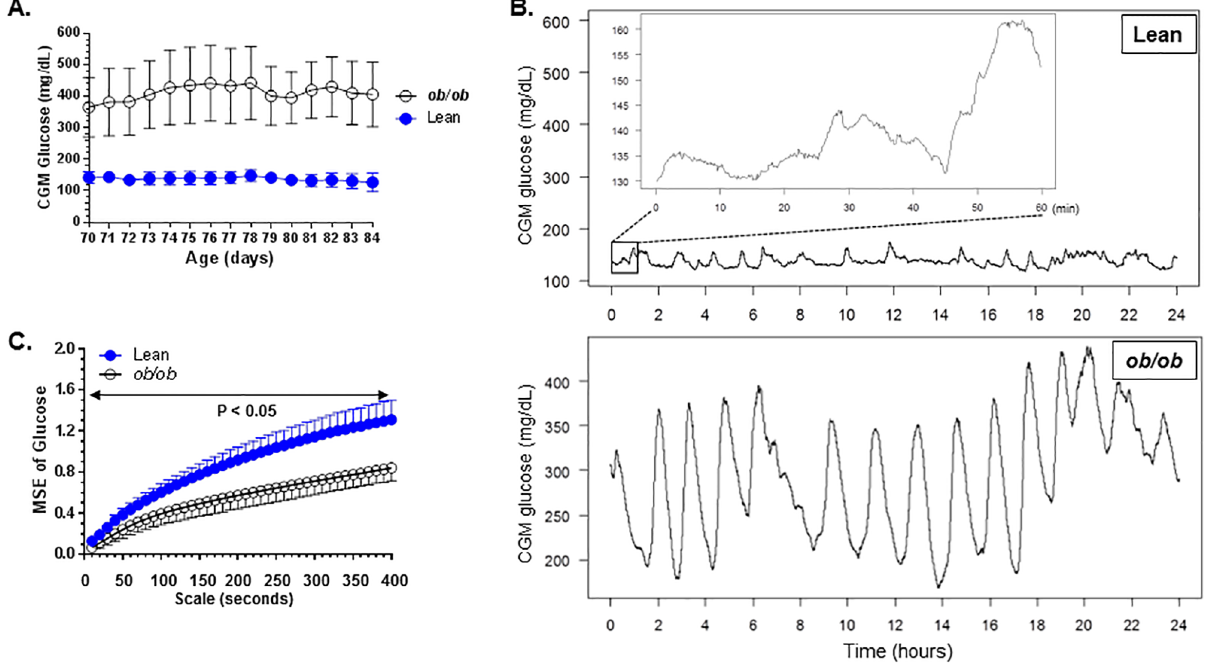
Fig 1. ( A ). Glucose levels of ob/ob mice and age-matched lean controls used for the study. Error bars, standarddeviation.N = 6 mice/ grouop. ( B ). Time series of blood glucoselevels derivedfrom CGM recordingsof a non-diabetic lean mouse and a diabetic ob/ob mouse duringa 24-hr period(age day 70 to 71). The inset is magnification of a one hour glucose data in a non-diabetic lean mouse. ( C ). Multiscale entropy analysison convertedglucose levels over Day 72 to Day 84 in ob/ob mice and lean controls (mean and standard deviation). The P values in Fig 1C were calculatedby performing unpairedt-tests for differencesin mean sample entropy between the two groupsof mice at the time scales